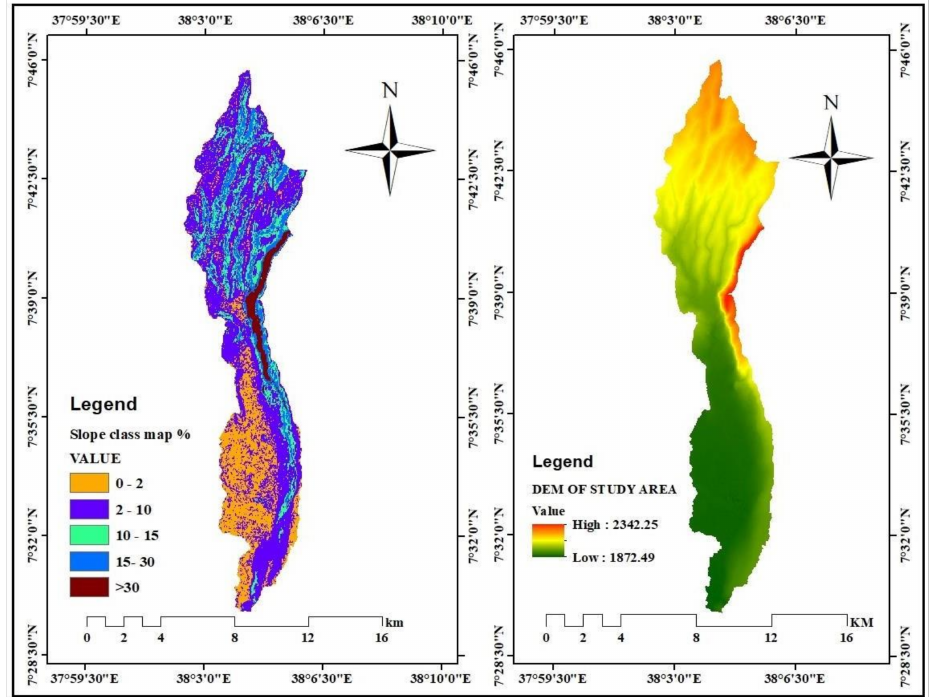
Figure 3. The slope class map and DEM of the Matenchose watershed.